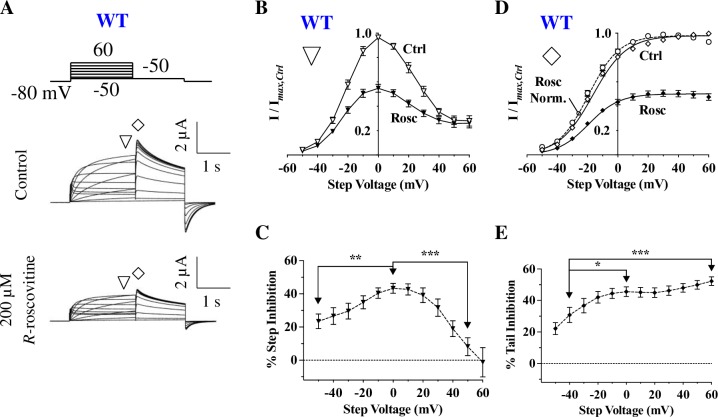
Characteristics of R-roscovitine inhibition of hERG channels.A) Voltage protocol and current traces from a representative cell expressing hERG channels before (Control) and during 200 μM R-roscovitine application. From a holding potential of -80 mV, outward currents were elicited at two phases: depolarization (from -50 mV to +60 mV) and repolarization (to -50 mV). Mean step currents were measured at the end of the 2-second step (▽) and tail currents were measured from their peak (◊). B) Normalized I-V curves for Control and 200 μM R-roscovitine from mean step currents (▽, n = 14). Inhibition was strongest between -30 mV and +30 mV, a range where the open state is more prevalent than either the closed or inactivated state. C) Average percent step current inhibition by 200 μM R-roscovitine at various step voltages. Inhibition was weakest at voltages where channels are closed (-50 mV) or inactivated (+50 mV; p = 0.0052 for 0 vs. -50 mV, p < 0.0001 for 0 vs. +50 mV, n = 14, one-way ANOVA). D) Tail I-V curves for Control and 200 μM R-roscovitine, with normalized peak tail currents (◊, n = 14). Smooth lines are Boltzmann fits to the activation curves, which produced significantly different V0.5 (Ctrl: -16.5 ± 1.1 mV, Rosc: -19.4 ± 1.1 mV; p = 0.0105, n = 14, paired t-test) and slopes (Ctrl: 11.7 ± 0.5, Rosc: 10.6 ± 0.5; p = 0.0114; n = 14, paired t-test). The dashed line shows a scaled activation curve in the presence of R-roscovitine. E) Average percent tail current inhibition by 200 μM R-roscovitine at various step voltages. The inhibition of tail current significantly increased with rising levels of depolarized potentials (p = 0.0134 for -40 vs. 0 mV, p = 0.0004 for -40 vs. +60 mV, n = 14, one-way ANOVA). Error bars represent standard errors; when not visible, error bars are smaller than the symbols. * = P < 0.05, ** = P < 0.01, and *** = P < 0.001.